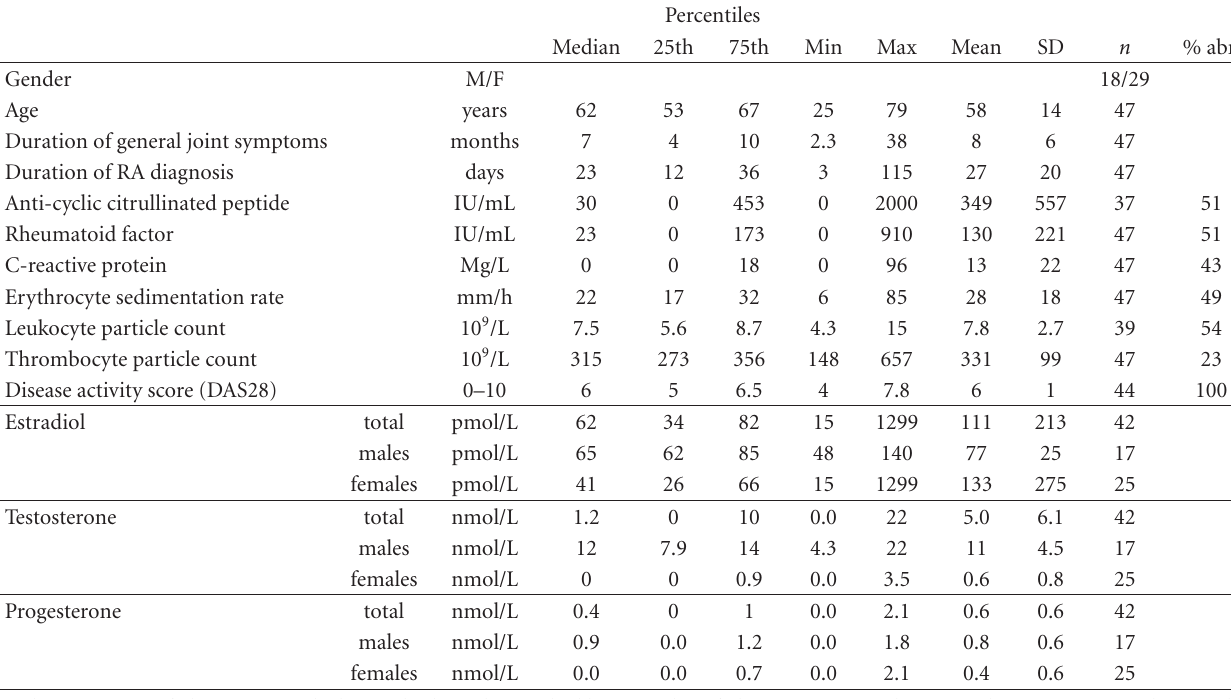
Table 1: Demographic and background data for 47 patients with early rheumatoid